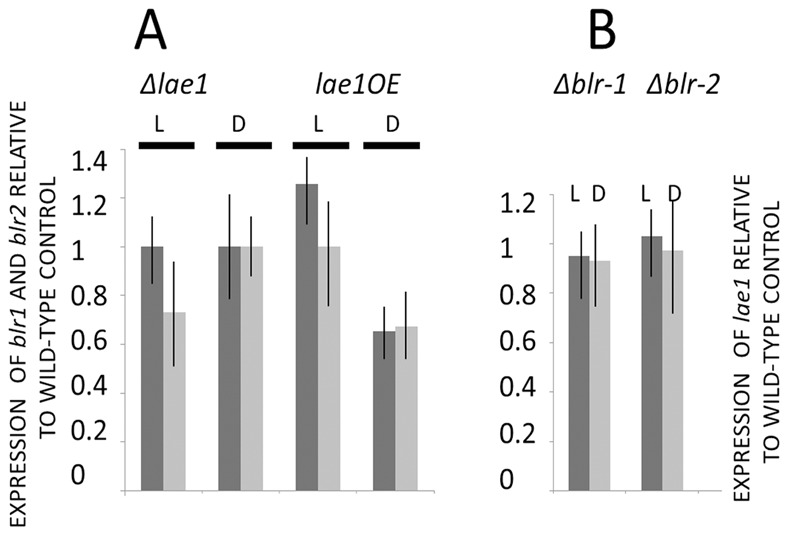
Effect of LAE1, and the blue light receptors BLR1 and BLR2 on each others expression: (A) Expression of blr1 (dark grey) and blr2 (light grey) in Δlae1-1 and OElae1 in light (L) and darkness (D); (B) expression of lae1 in Δblr1 and Δblr2 in light (L) and darkness (D).Vertical bars indicate the standard deviation (N ≥3). Expression of lae1, blr1 and blr2 was normalized to the expression of tef1. Relative gene expression is calculated as the ratio of the normalized expression in the mutant in –fold of that of the parent strain P1. None of the difference was found to be statistically relevant by students t-test (p>0.15).